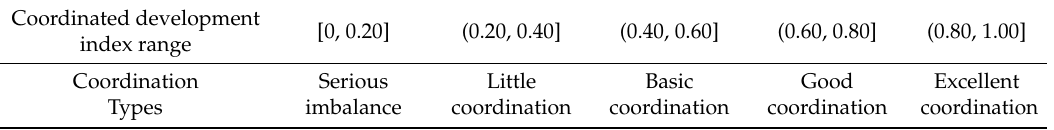
Table 3. Five levels of coordinated development index (CDI) for